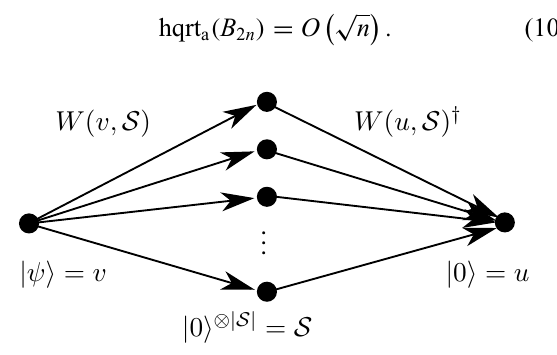
FIG. 7. In our routing protocol for the vertex barbell graph, we transfer the state | ψ (cid:8) on qubit v to u by using the intermediate qubits S as ancillas (in the | 0 (cid:8) ⊗| S | state). The operation W (v , S ) encodes | ψ (cid:8) in a subspace spanned by | 0 (cid:8) ⊗| S | and the W state in (cid:21) | S | ) [72]. Since this procedure is unitary, we can use time π/( 2 its inverse to transfer the state to u . We repeat this procedure in G R to transfer the state to its